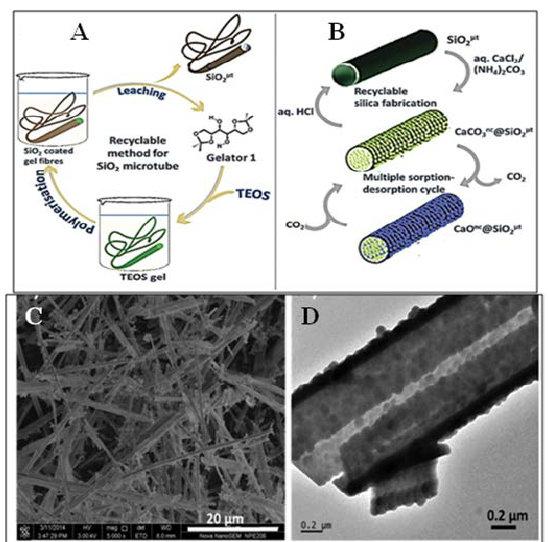
Figure 30. Schematic Proposal for ( A ) large-scale preparation of hollow silica microtubes using recyclable organogel template and ( B ) use of silica microtubes as a platform for growing CaO nanocrystals and their use as sintering-free sorbent for multicycle calcium looping; ( C ) SEM image of silica microtubes after growing CaCO 3 nanocrystals over their surface; ( D ) TEM image of the CaCO 3 nc-grown-SiO 2 microtubes, showing the growth of CaCO 3 nanocrystals on either surface of the SiO 2 tubes. Reprinted with permission from [126]. Copyright 2016 Royal Society of Chemistry.